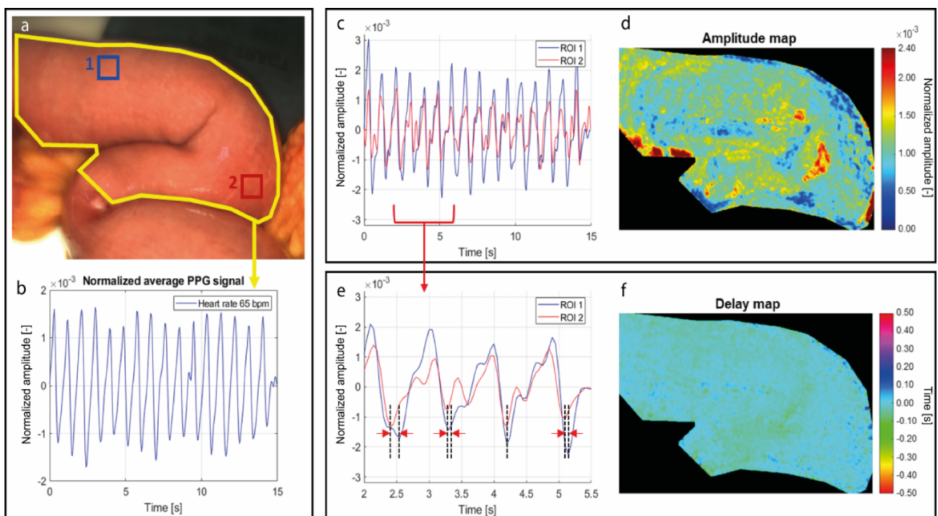
Figure 3. PPG signals and PPG maps extracted from videos. ( a ) RGB image of the recorded intestine area. The yellow contour represents the entire region of interest, the blue and red squares represent smaller, spatially different ROIs. ( b ) Global PPG signal extracted from the entire region of interest (yellow contour). ( c ) PPG signals extracted from ROI1 (blue) and ROI2 (red). ( d ) PPG amplitude map, which represents the amplitude of the PPG signal in each pixel. ( e ) Zoom-in of the PPG signals extracted from ROI1 and ROI2. The dotted lines indicate the variable time delay between each PPG wave arrival. ( f ) PPG delay map, which represents the average delay in the PPG wave arrival of each pixel, with respect to the global PPG